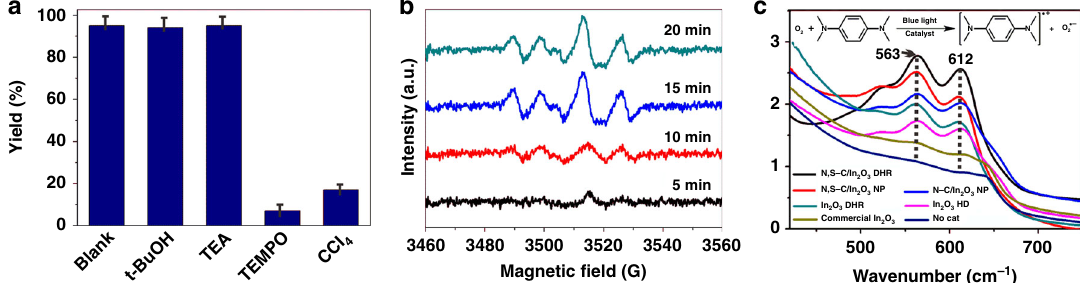
Fig. 6 Photocatalytic mechanism studies. a Control experiments for OHAA over N,S-C/In 2 O 3 DHR under blue LED irradiation in the presence of different scavengers: no scavenger (blank), t-BuOH, TEA, TEMPO, and CCl 4 . b EPR spectra of a reaction solution in the present of DMPO under blue LED irradiation for different times. c UV – vis absorption spectra for cationic radicals of TMPD treated by N,S-C/In 2 O 3 DHR, N,S-C/In 2 O 3 NP, N-C/In 2 O 3 NP, In 2 O 3 DHR, In 2 O 3 HD, and commercial In 2 O 3 under blue LED light irradiation. Source data are provided as a Source Data